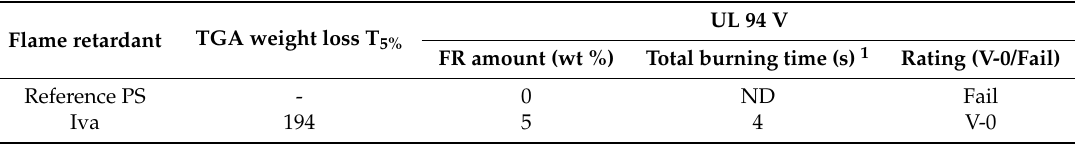
Table 4. UL 94 V test results for